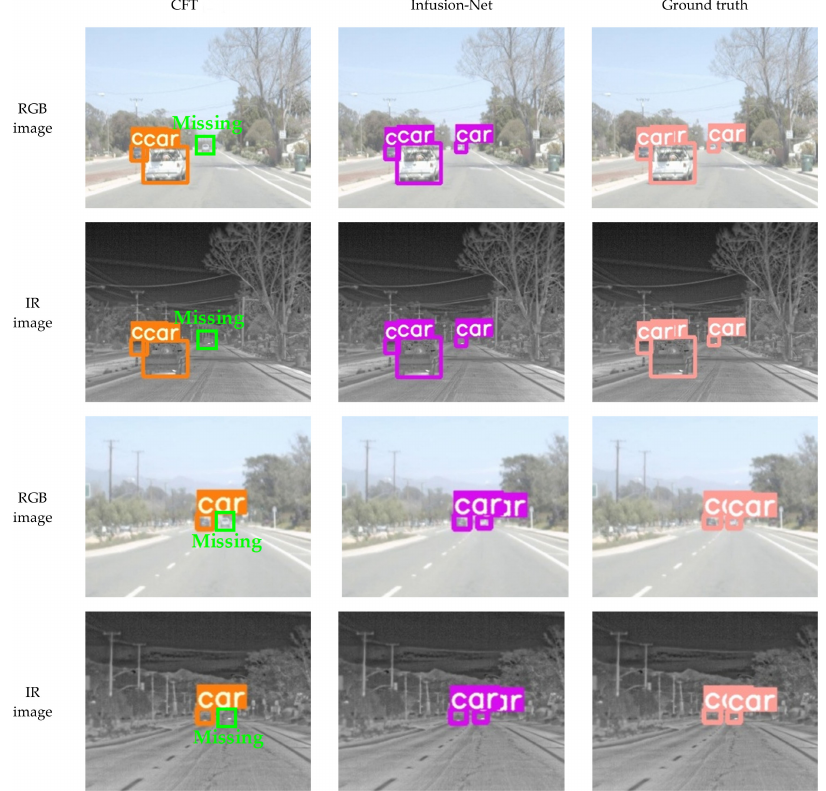
Figure 10. Qualitative comparison of the Infusion-Net results and CFT [25] results on the FLIR dataset. Green boxes denote missing